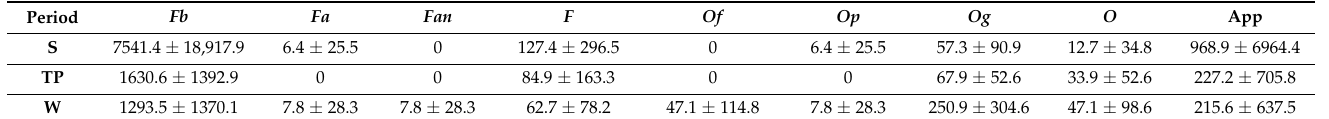
Table 1. Abundance (mean ± SDs) (ind. 10 3 m − 3 ) of Appendicularia in Admiralty Bay in summer (S), transition period (TP), and winter (W) seasons in the surface layer; App—Appendicularia, Fb — Fritillaria borealis , Fa — F. aberrans , Fan — F. antarctica , F — Fritillaria sp., Of — Oikopleura fusiformis , Op — O. parva , Og — O. gaussica , and O — Oikopleura sp.